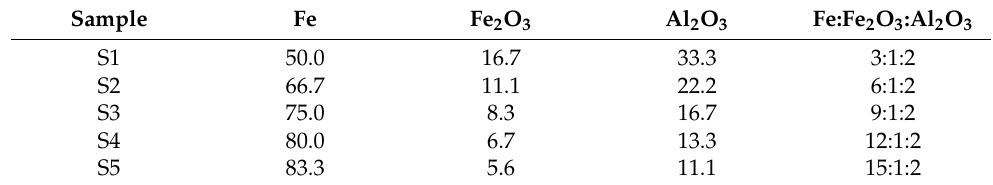
Table 1. Chemical composition with different Fe proportion for each sample